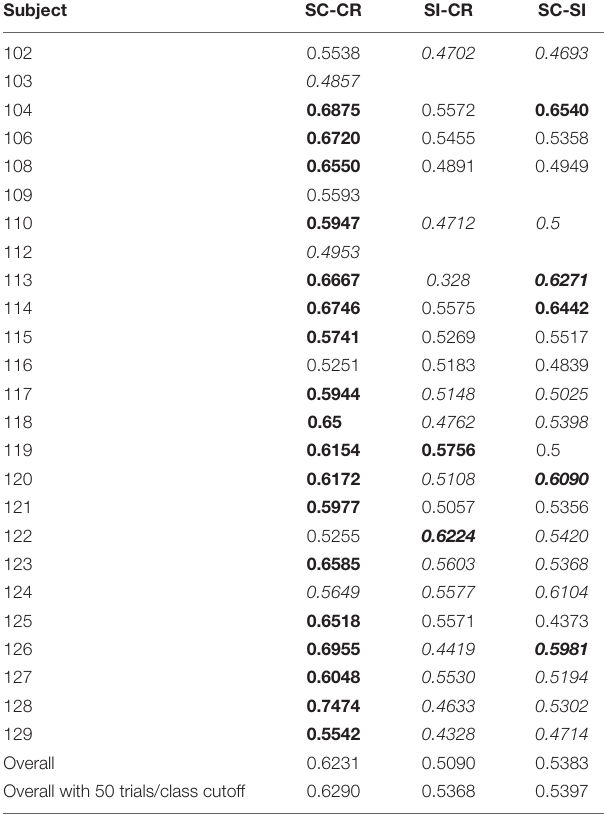
TABLE 1A | Classification results for Experiment 1.